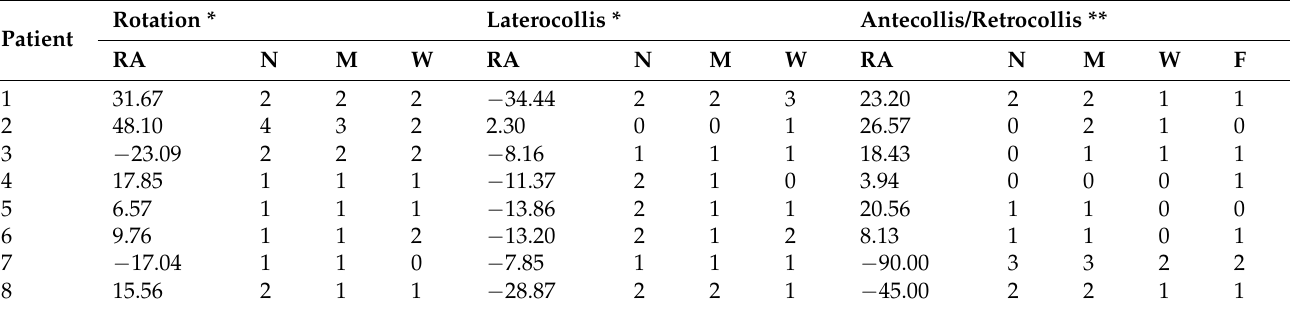
Table 2. Score of the subscales of the TWSTRS severity scale calculated by the multi-view vision based method, a neurologist trained in movement disorders, and the wearable inertial sensors based method.